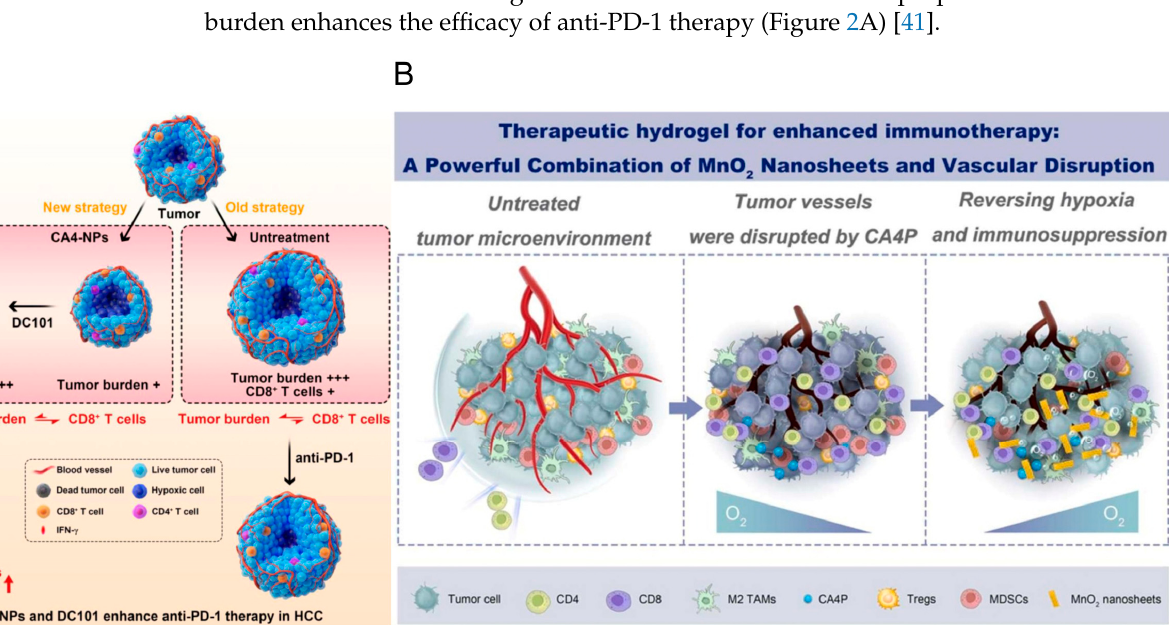
Table 2. Combined therapeutic paradigms of antivascular therapy and chemotherapy .